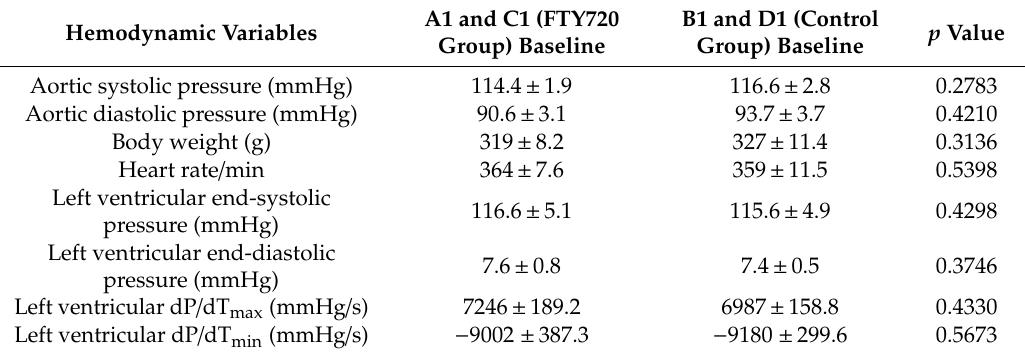
Table 1. Baseline parameters of Fingolimod (FTY720) treated group and control